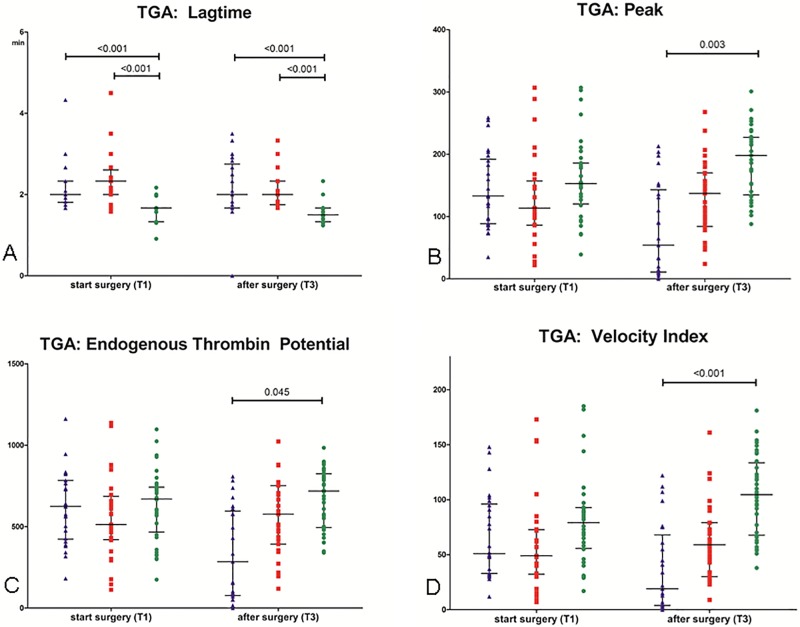
Thrombin generation assays.Fig 5A. TGA lagtime (A). Preemptive group (blue triangle), non-preemptive group (red square) and donors (green dot) before incision (T1) and 2 hours after surgery (T3). Data are given as medians with IQR. Fig 5B. TGA peak. Preemptive group (blue triangle), non-preemptive group (red square) and donors (green dot) before incision (T1) and 2 hours after surgery (T3). Data are given as medians with IQR. Fig 5C. TGA endogenous thrombin potential (ETP). Preemptive group (blue triangle), non-preemptive group (red square) and donors (green dot) before incision (T1) and 2 hours after surgery (T3). Data are given as medians with IQR. Fig 5D: TGA velocity index. Preemptive group (blue triangle), non-preemptive group (red square) and donors (green dot) before incision (T1) and 2 hours after surgery (T3). Data are given as medians with IQR.